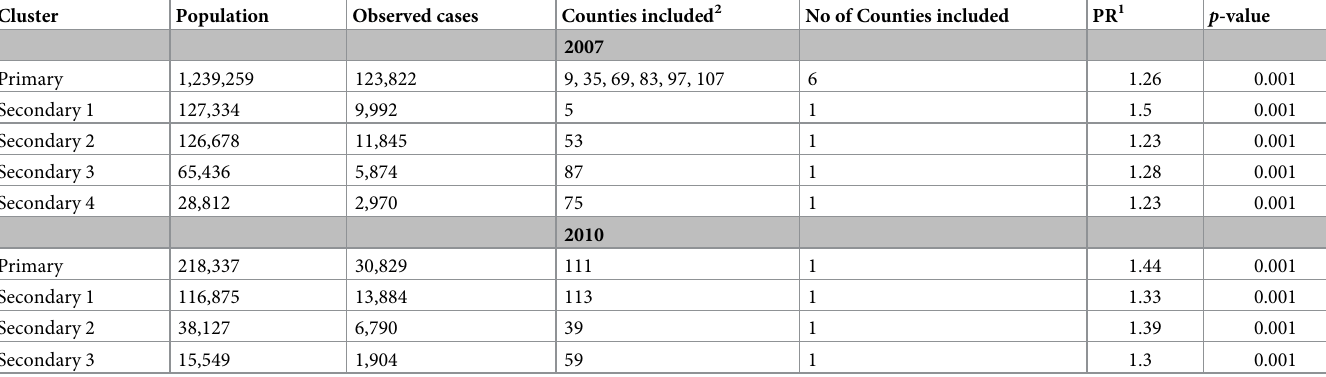
Table 3. Purely spatial risk-factor adjusted high-prevalence diabetes clusters in Florida, 2007 and 2010.